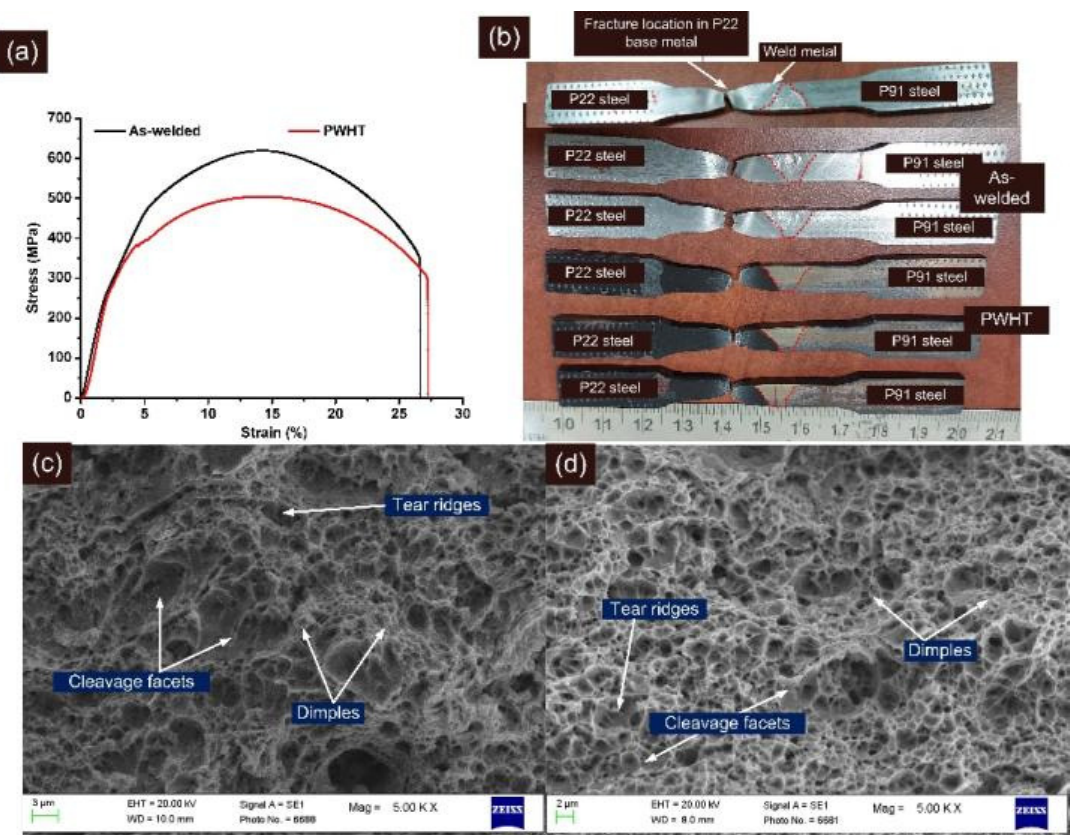
Figure 13. ( a ) Stress–strain curve for tensile tested specimen, ( b ) fractured tensile specimen, ( c ) fractured surface image for AW joint, ( d ) PWHT joint.